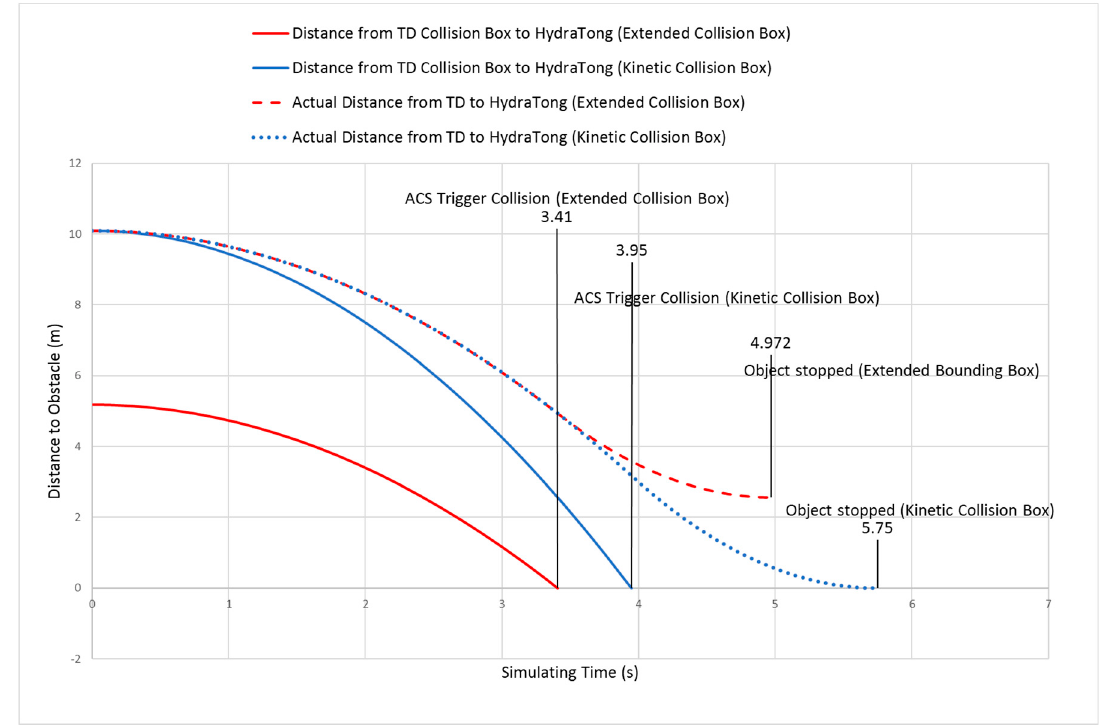
Figure 16. Comparison of the functionalities of the kinematic collision box and the Extended Bounding Box. J. Mar. Sci. Eng. 2020 , 8 , x FOR PEER REVIEW